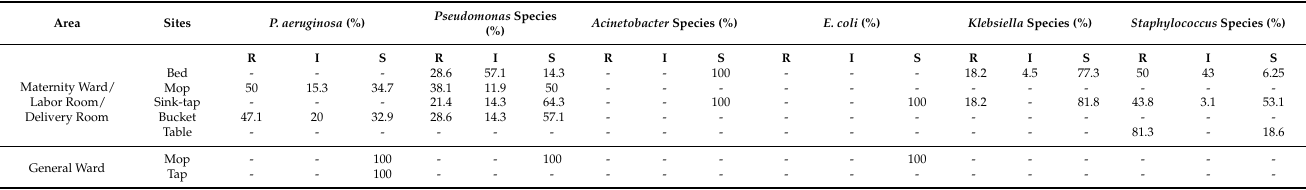
Table 2. Antibiotic resistance pattern among isolated pathogens from different environment sur- faces of maternity wards, labor rooms, and general wards of the selected healthcare facilities of Gujarat,